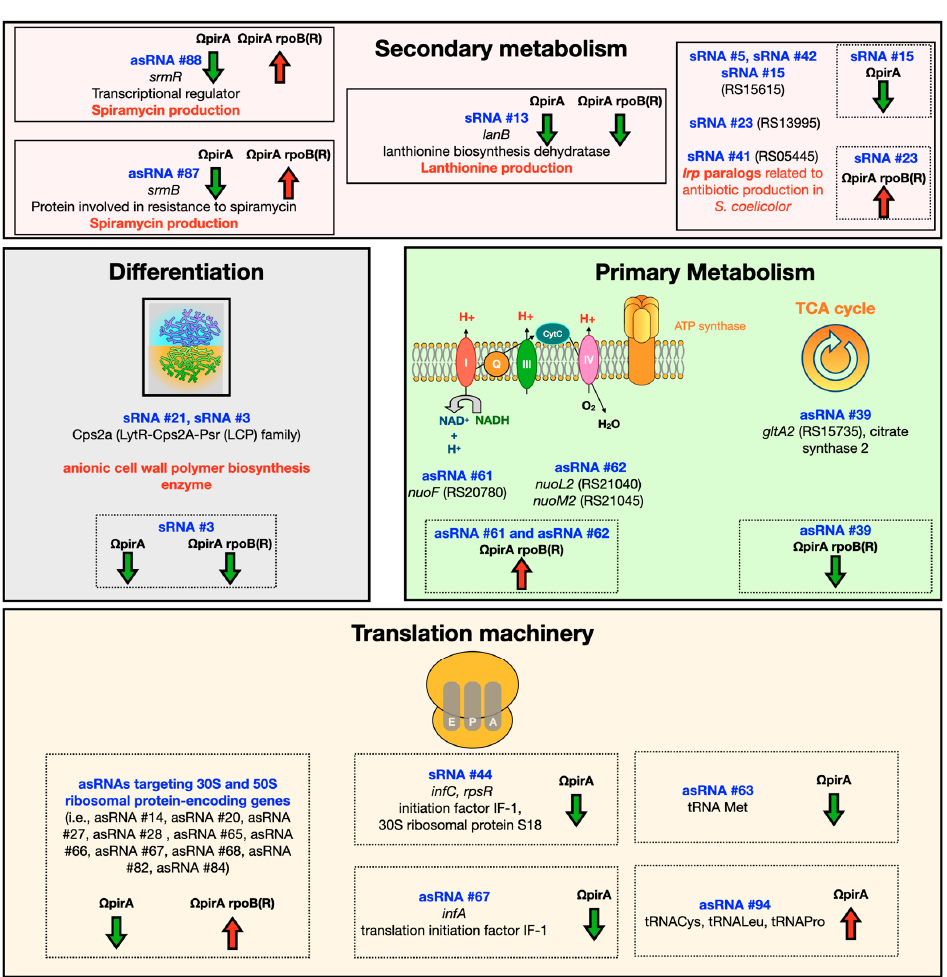
Figure 8. A summarized scheme depicting the up or downregulated ncRNA involved in secondary metabolism, morphological development, primary metabolism, translation, and ribosomal struc- ture.